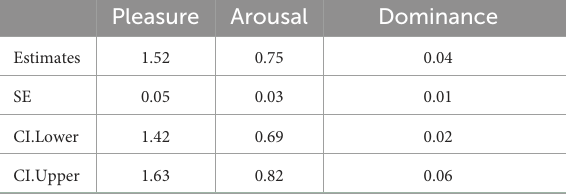
TABLE 3 Goodness-of-fit indices for path analysis.